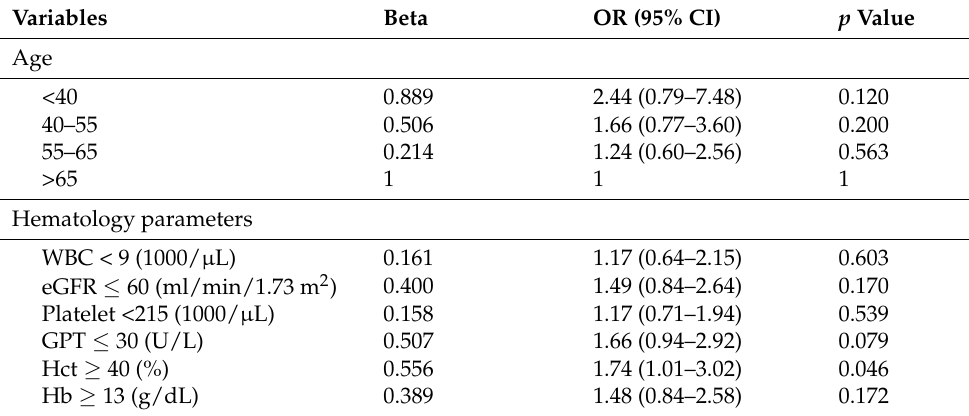
Table 2. Conditional logistic regression analysis for RAO